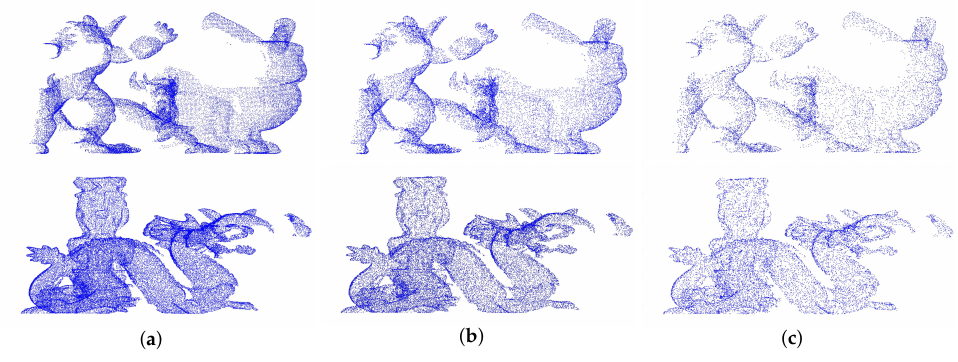
Figure 10. Examples of scenes with different mesh resolution. ( a ) 75%. ( b ) 50%. ( c )